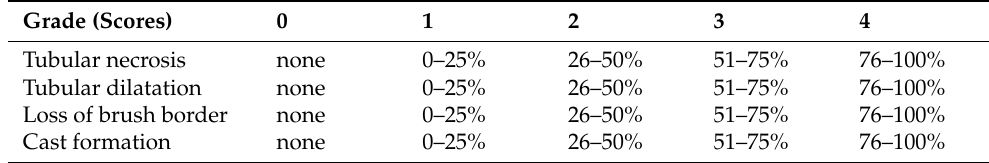
Table 2. Kindy histological scoring